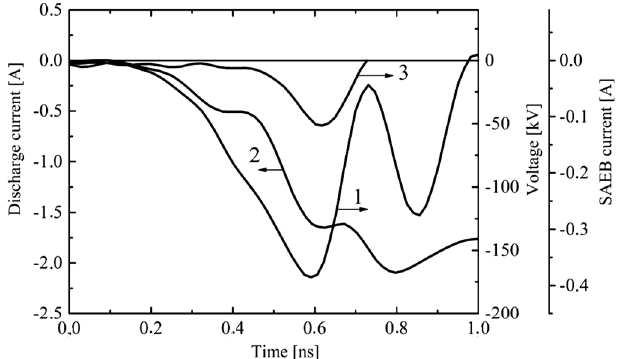
FIG. 2. Typical waveforms of the voltage pulse from capacitive dividers located near the gas diode (1), current through gap (2) and SAEB current (3) in SF 6 at atmospheric pressure. Interelectrode distance d ¼ 8 mm.